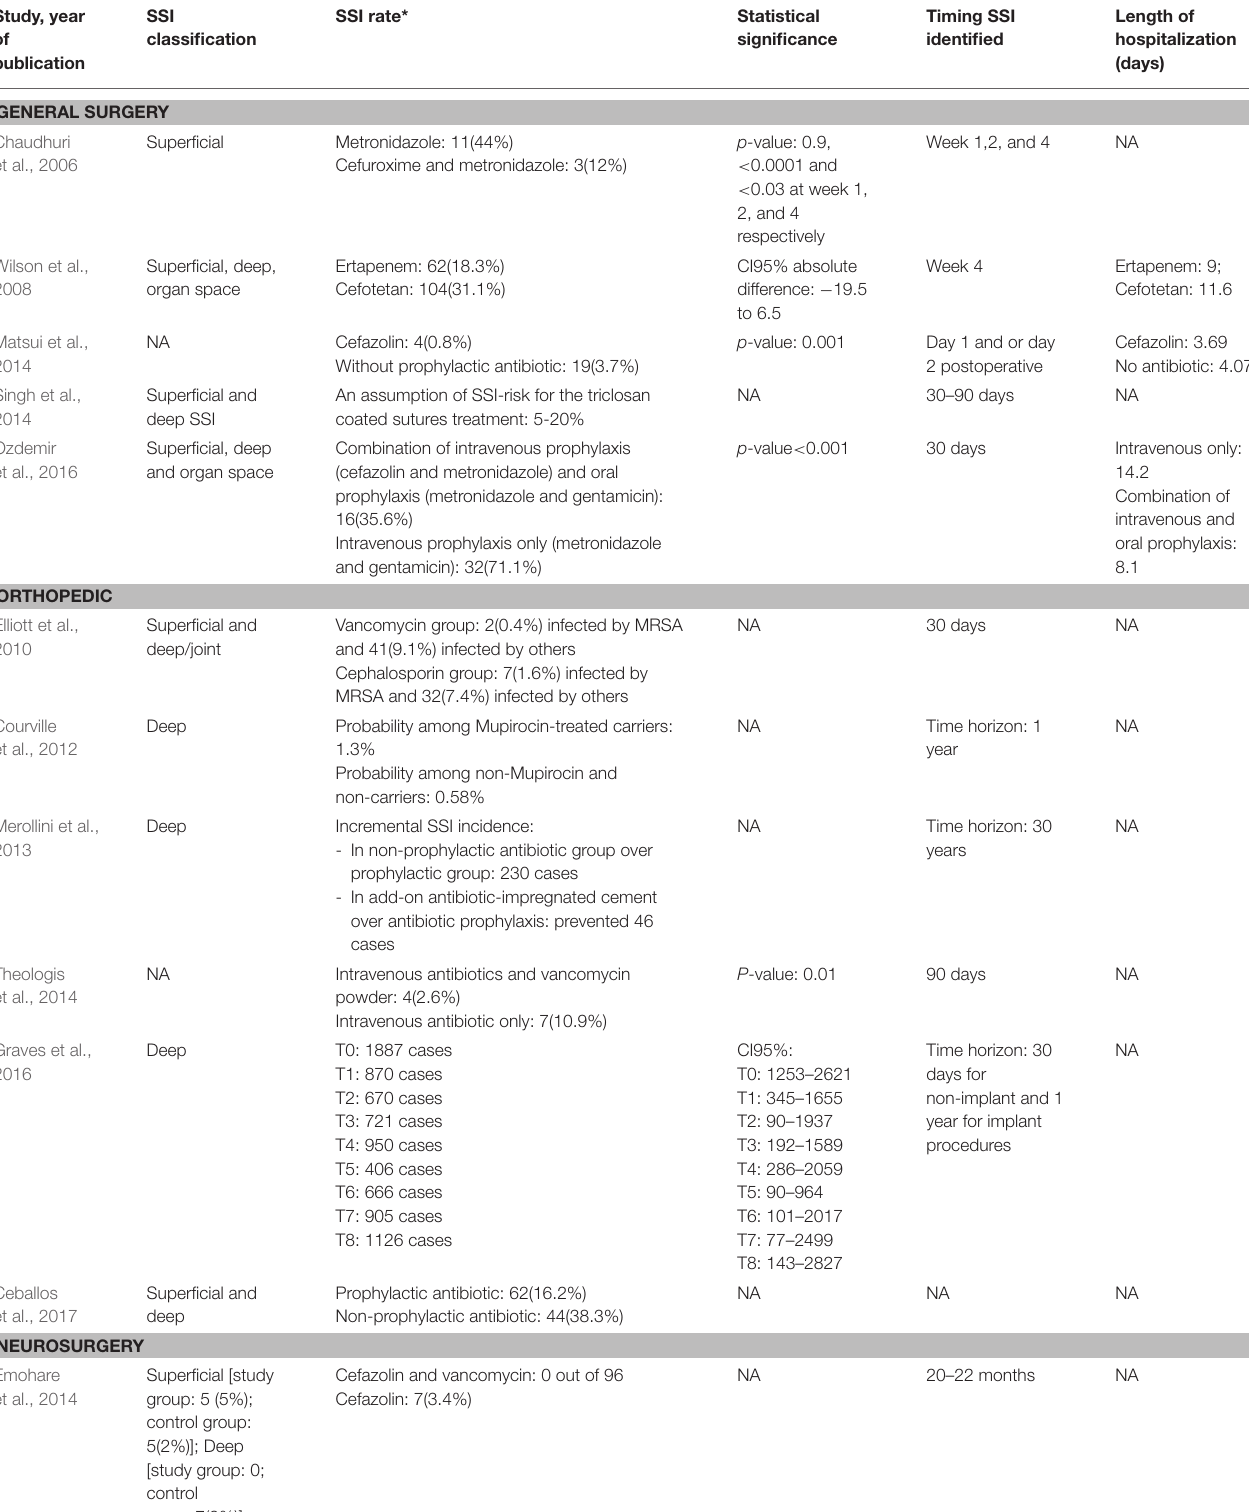
TABLE 4 | Comparison of selected studies on reporting of SSI classification, SSI rate, statistical significance, timing at the identification of the SSI and length of hospitalization. Study, year